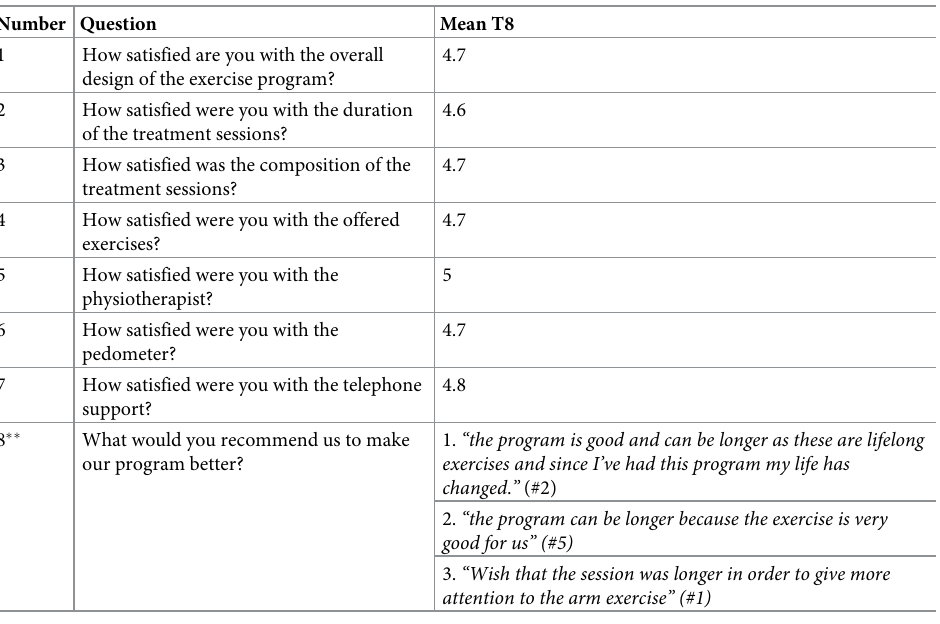
Table 3. Patient satisfaction and